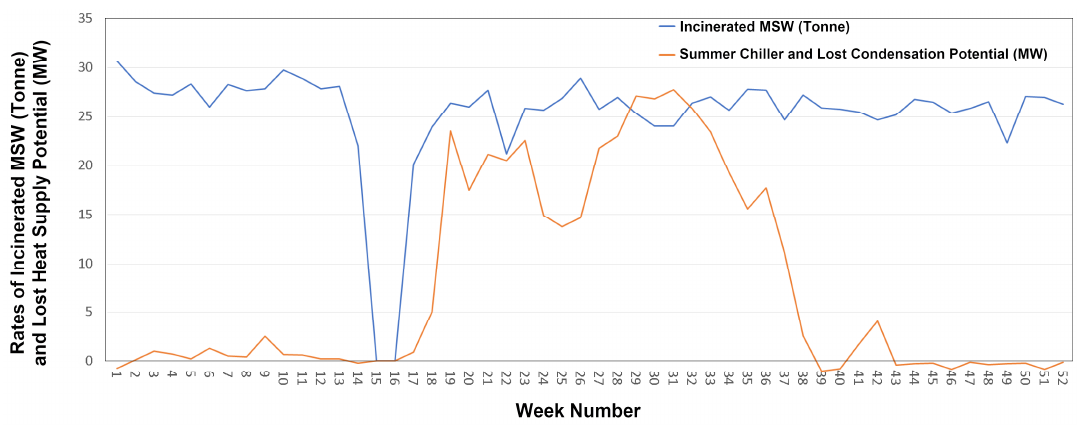
Figure 3. Rate of wasted MSW (in tonnes / week) and wasted heat supply potential of the plant (in MW) for a year.